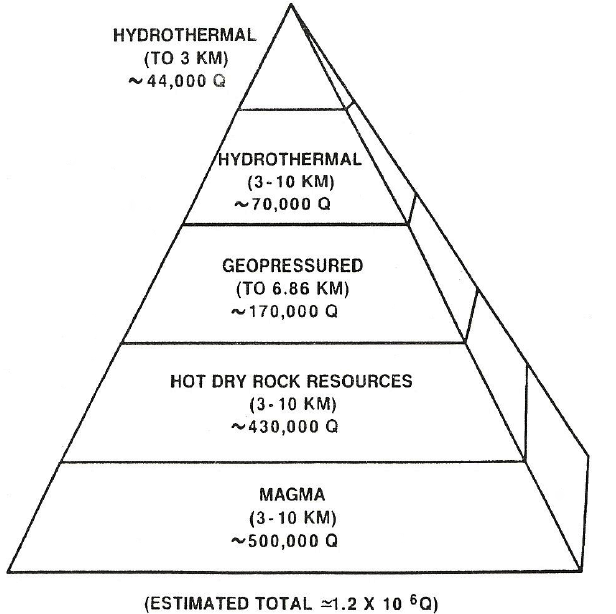
Figure 7. An early estimate of the resource base in various geother- mal environments indicated that magma-ambient systems have a very large potential. Q = quad or 10 15 BTU or about 1 exa- joule = 10 18 J (source: White and Williams, 1975, USGS Circular